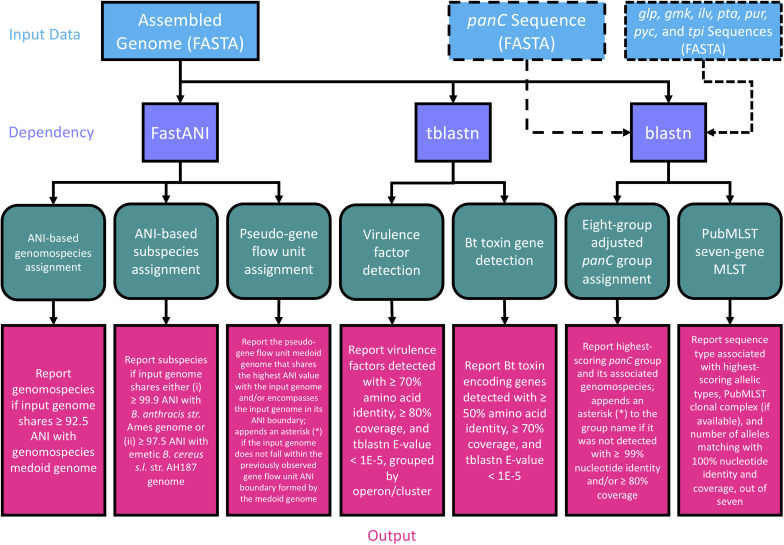
Flow chart describing the workflow implemented in BTyper3 v. 3.1.0. Input data in FASTA format (blue boxes) can consist of any of the following: (i) a whole genome (complete or draft; can be used with all/all combinations of workflow steps), (ii) a panC sequence (can be used with the eight-group adjusted panC group assignment workflow only), or (iii) sequences of the seven loci used in PubMLST’s seven-gene multi-locus sequence typing (MLST) scheme for B. cereus s.l. (sequences can be in multi-FASTA format, or concatenated into a single sequence; can be used with the PubMLST seven-gene MLST workflow only). Purple boxes represent software dependencies required for each type of input data, while green boxes represent the various analyses that can be conducted in BTyper3 v. 3.1.0. Pink boxes denote the output that BTyper3 v. 3.1.0 reports for each analysis.